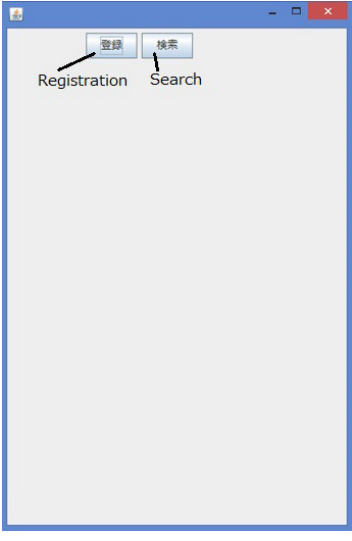
Fig. 7. Selection window.